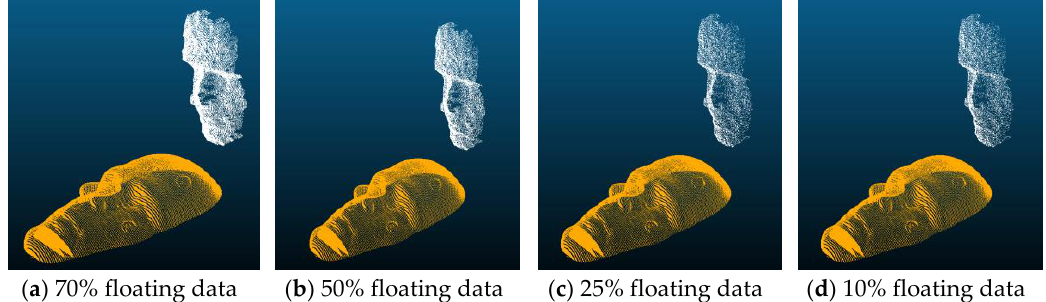
Figure 4. Examples of sparse floating (white) and reference points (gold) used in the experiments. Table 1. The Average, Minimum and Maximum of Reference Points’ Alignment Errors .